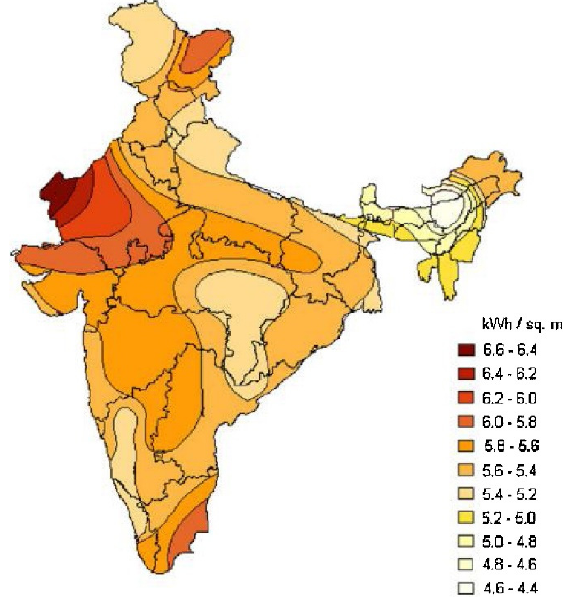
Figure 6. Physical map Indian solar radiation[139].